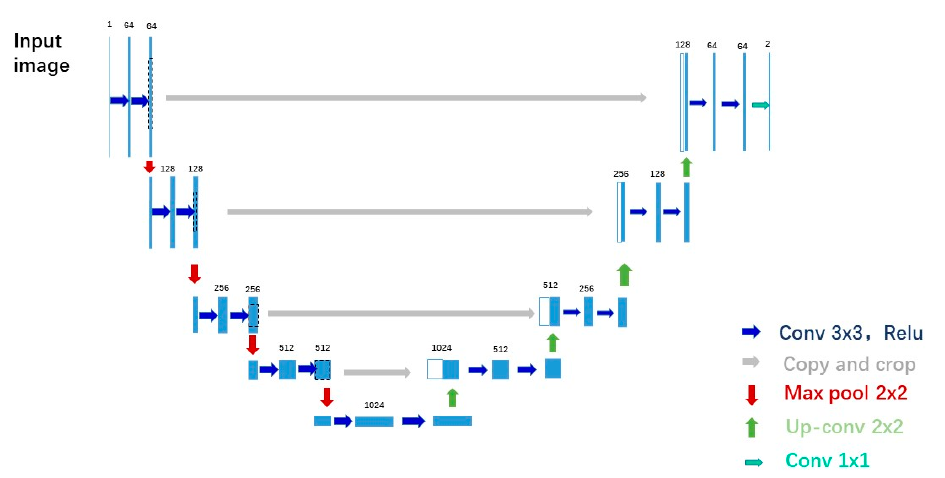
Figure 1. U ‐ Net Network Structure Diagram. Figure 1. U-Net Network Structure